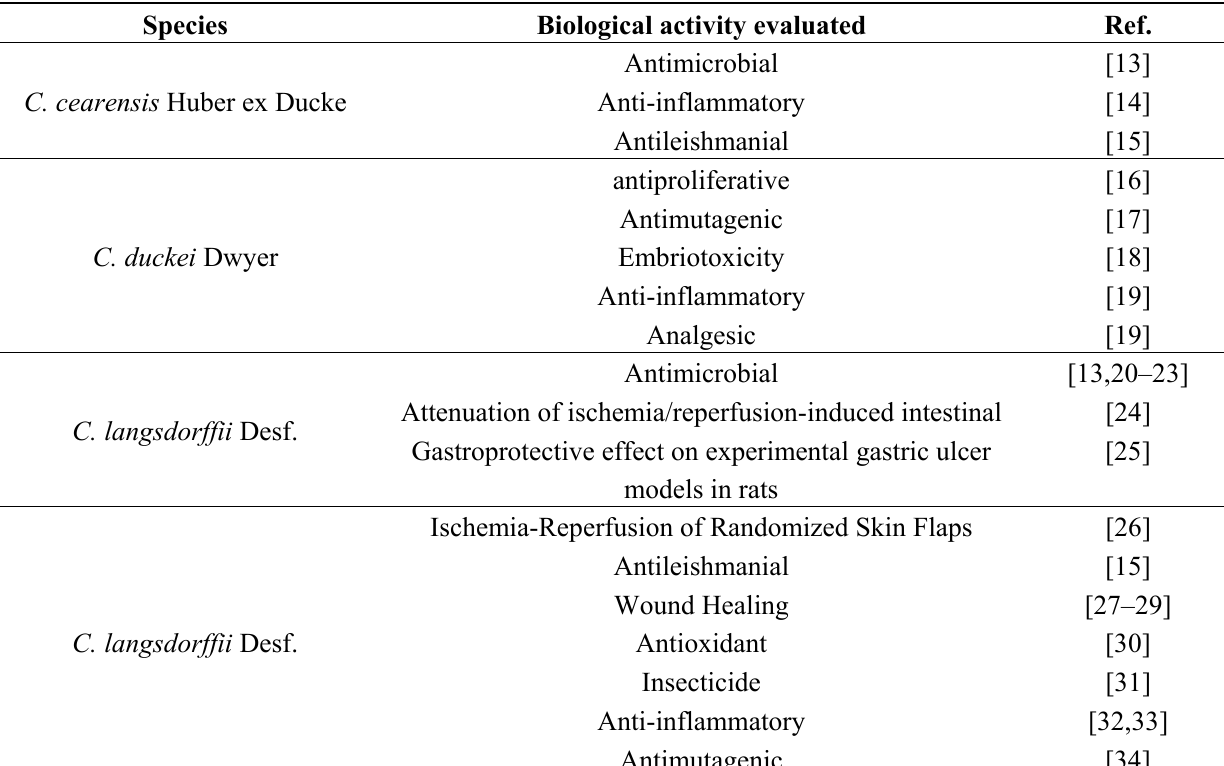
Table 1. Biological activities tested in different species of Copaifera